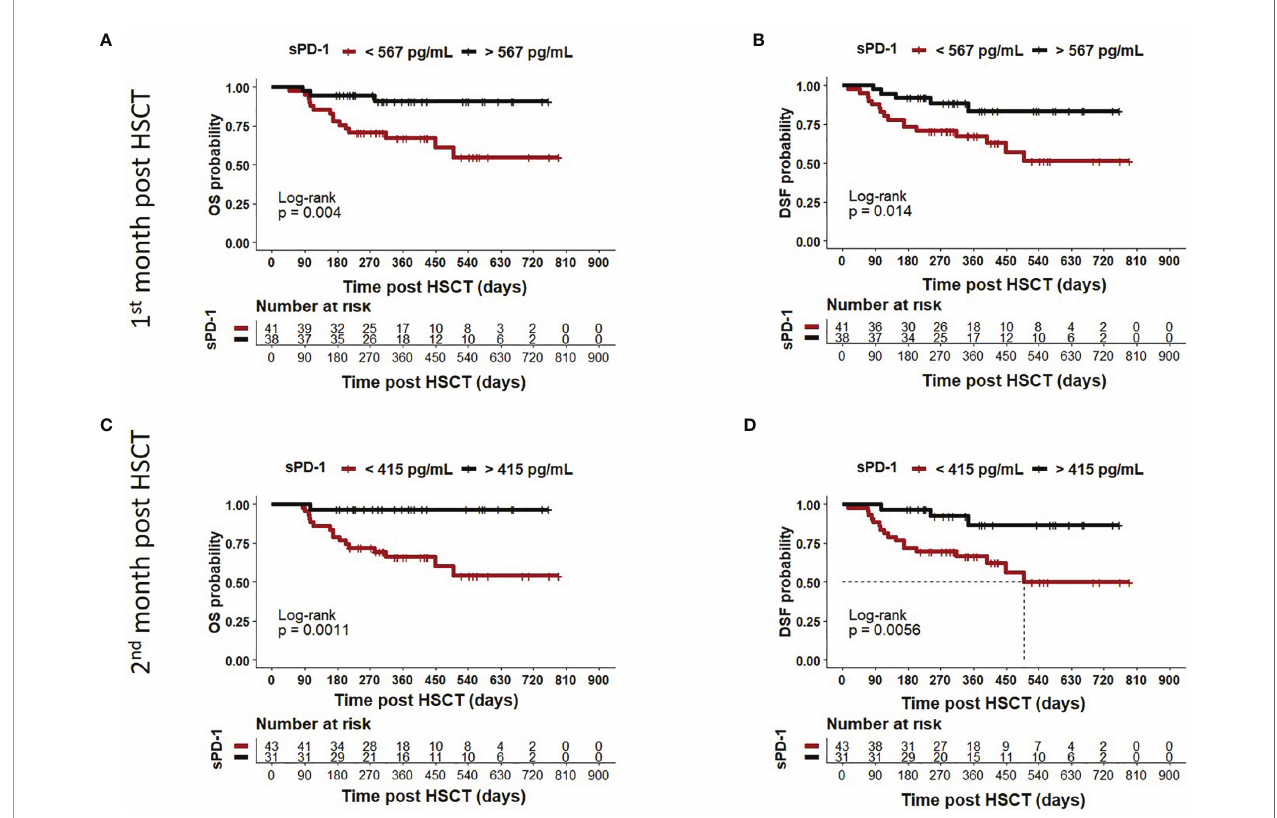
FIGURE 5 | Association of low sPD-1 levels with reduced OS and DFS. Patients were divided in two groups according to cut-off levels obtained one (A, B) month (< or >567 pg/ml) and two (C, D) months (< or >415 pg/ml) post HSCT. The corresponding Kaplan-Meier curve of overall survival (OS) or disease-free survival (DFS) probability combined with Log-rank test with respect to sPD-1 cut-offs are shown. Patients with sPD-1 below the thresholds in brown showed reduced OS (p=0.004 or p=0.011) and DFS (p=0.0014 or p=0.0056) compared with patients with sPD-1 levels above these values. Dotted line indicates median DFS post HSCT in (D) . Due to death or loss of follow up, data were not available for all 82